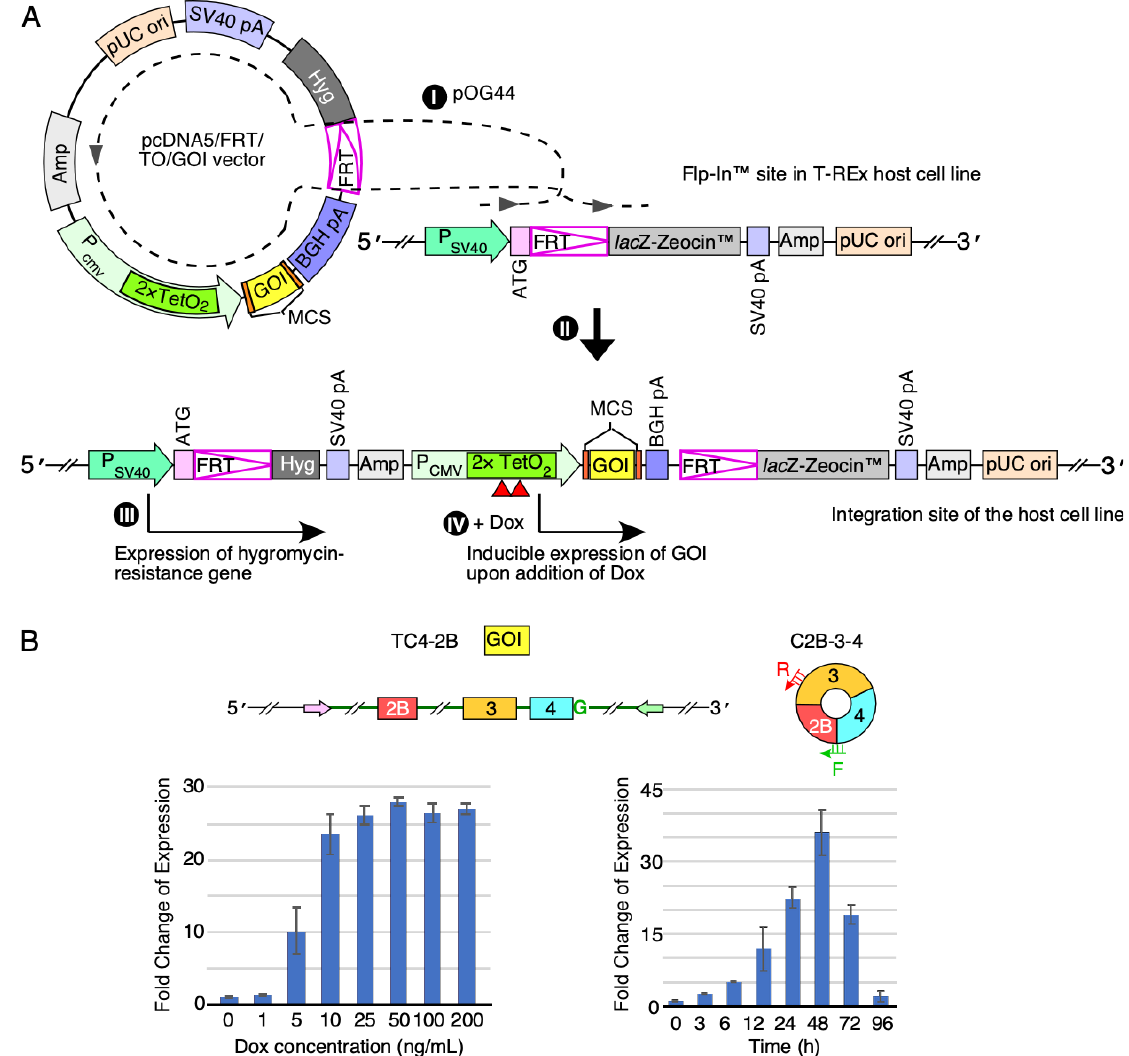
Figure 4. Establishment of inducible stable cell lines to overexpress SMN circRNAs. ( A ) Left panel: diagrammatic representation of Flp-In system used to generate a stable cell line with inducible ex- pression of a gene of interest (GOI) (edited from https://www.thermofisher.com/order/cata- log/product/V652020#/V652020 (accessed on 15 January 2021)). (I) Co-transfection of pcDNA5/FRT/TO/GOI vector (expression vector for a GOI) and pOG44 (expression vector for Flp recombinase) into a host cell line that contains an FRT (Flp recombination target) site at a specific location in the genome; (II) integration of pcDNA5/FRT/TO/GOI vector at the FRT site mediated by Flp recombinase; (III) selection for cells resistant to hygromycin (resistance is provided by stably integrated pcDNA5/FRT/TO/GOI); (IV) induction of GOI expression by doxycycline (Dox) and anal- ysis. Dox addition is indicated by red triangles. The diagram is not to scale. Relevant abbreviations: GOI, gene of interest; MCS, multiple cloning site; Hyg , hygromycin-resistance gene; Amp , ampicil- lin-resistance gene; TetO 2 , tetracycline operator, Dox, doxycycline. ( B ) Establishing the optimal reg- iment, including Dox dosage and induction duration, for C2B-3-4 expression in the stable cell line we called TC4-2B. Left panel: bar diagram showing the fold change of C2B-3-4 expression in re- sponse to different Dox concentrations (ng/mL). For fold change, the expression level at 0 ng/mL was normalized to a value 1. Right panel: bar diagram showing the fold change of C2B-3-4